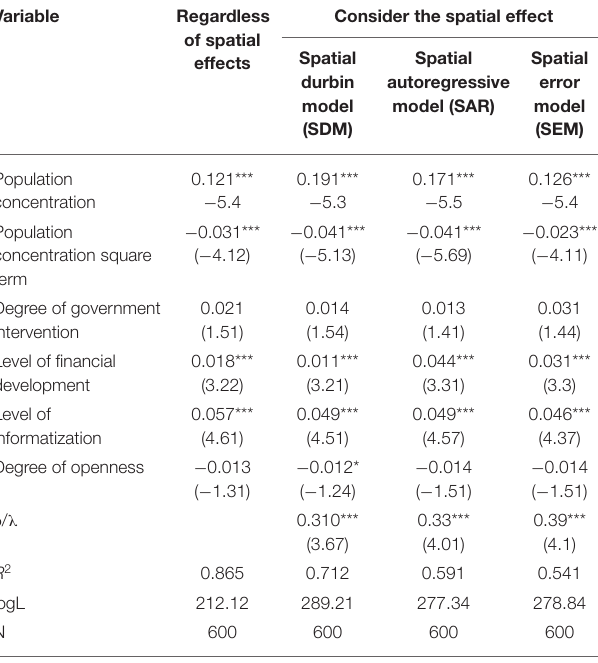
TABLE 5 | Regression results of a spatial model of population agglomeration affecting high-quality development. Variable